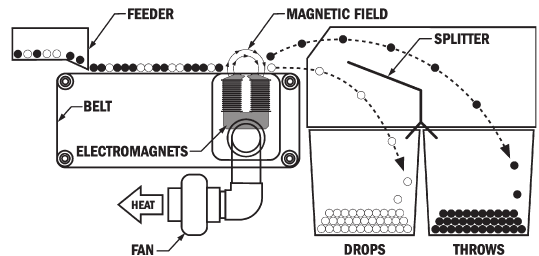
Fig. 1 Schematic diagram of the EDX embodiment with elec- tromagnet cores placed directly underneath the con- veyor belt.